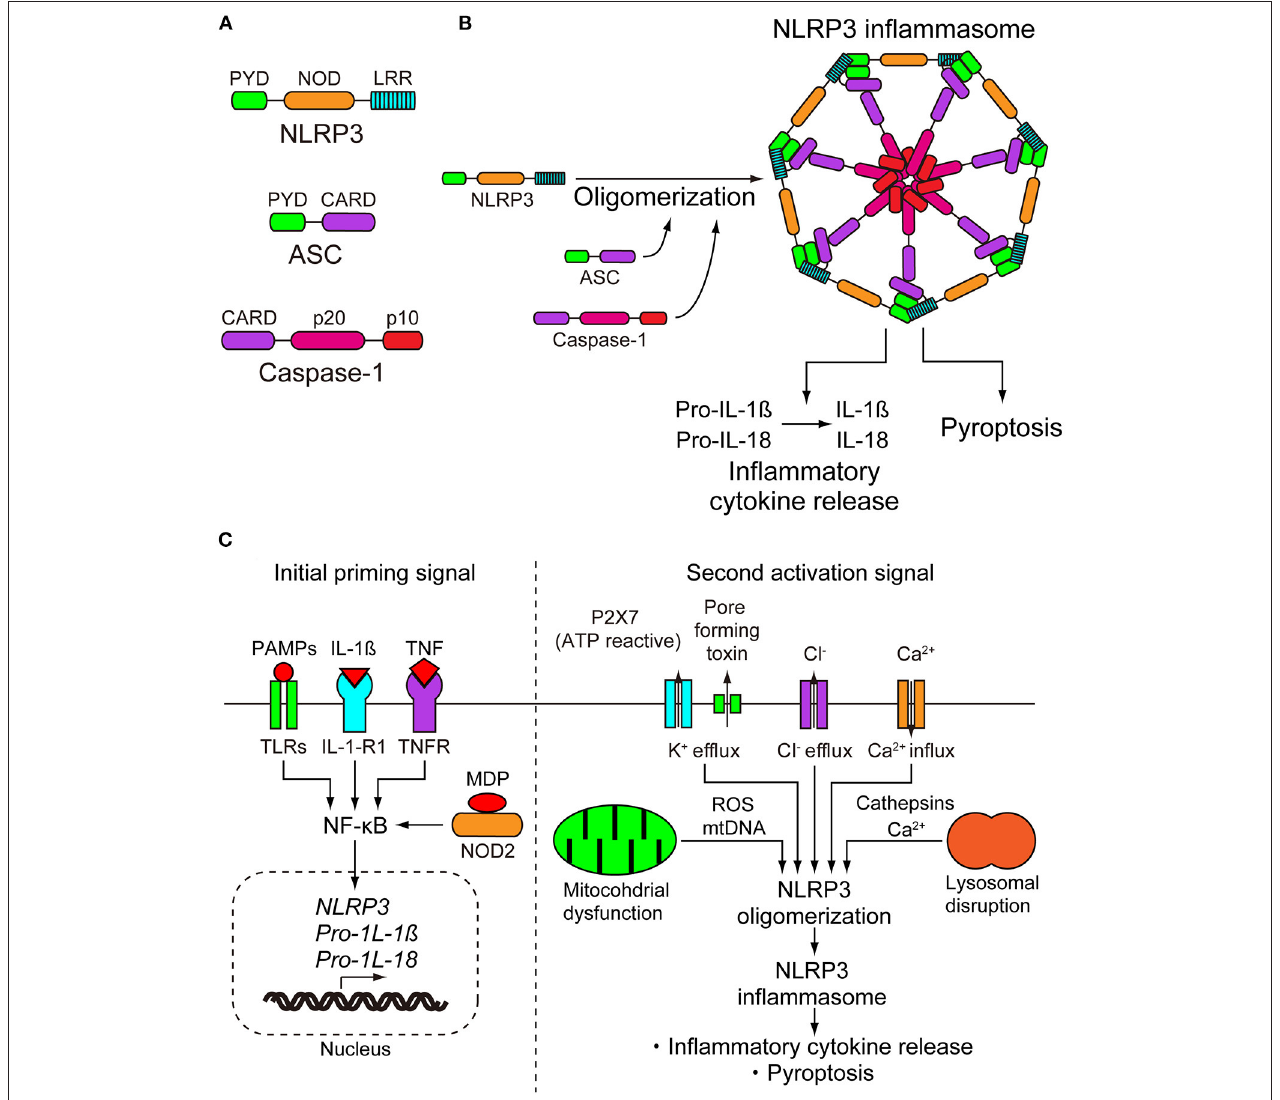
FIGURE 1 | NLRP3 inflammasome. (A) NLRP3 inflammasome consists of NLRP3, apoptosis-associated speck-like protein containing a caspase-recruitment domain (ASC), and caspase-1. NLRP3 consists of an N-terminal pyrin (PYD) domain, a central nucleotide-binding oligomerization domain (NOD), and a leucine-rich repeat (LRR) domain at the C terminus. ASC has two interaction domains, N-terminal PYD and C-terminal caspase-recruitment domain (CARD). Caspase-1 has N-terminal CARD, a central large catalytic domain (p20), and C-terminal small catalytic domain (p10). (B) On stimulation, NLRP3 oligomerizes through the homotypic interactions of NODs. Oligomerized NLRP3 recruits ASC through PYD-PYD interactions and induces filament formation of ASC. Multiple ASC filaments combine to form a macromolecule. Assembled ASC recruits caspase-1 through CARD-CARD interactions, leading to formation of the NLRP3 inflammasome, and enables self-cleavage of caspase-1. Caspase-1 assembled on ASC self-cleaves into a complex of CARD-p20 and p10. CARD-p20 is proteolytically active and induces the maturation of interleukins-1 β and − 18 (IL-1 β and IL-18) and pyroptosis. (C) Activation of NLRP3 requires a two step-signals, priming and activation. The initial priming signal causes the upregulation of the expression of NLRP3 inflammasome components NLRP3, pro-IL-1 β , and pro-IL-18. The transcriptional upregulation can be induced through the recognition of pathogen-associated molecular patterns (PAMPs) and damage-associated molecular patterns (DAMPs). PAMPs and DAMPs are recognized by pattern recognition receptors including toll-like receptors (TRLs) and nucleotide-binding oligomerization domain-containing protein 2 (NOD2) or by cytokines including IL-1 β and tumor necrosis factor (TNF), leading to nuclear factor- κ B (NF- κ B) activation and gene transcription. The second activation step begins with the recognition of NLRP3 activator and induction of NLRP3 inflammasome formation. NLRP3 can be activated by a wide range of unrelated stimuli. Due to their biochemical diversity, it is suspected that they induce a common cellular pathway. However, multiple signaling events have been observed in the activation of NLRP3 inflammasome, including efflux of potassium or chloride ions, flux of calcium ions, disruption of lysosomes, dysfunction of mitochondria, and production of reactive oxygen species. To date, there is no consensus model for the activation of the NLRP3 inflammasome. IL-1-R1, IL-1 receptor type 1; MDP, muramyl dipeptide; ROS, reactive oxygen species.